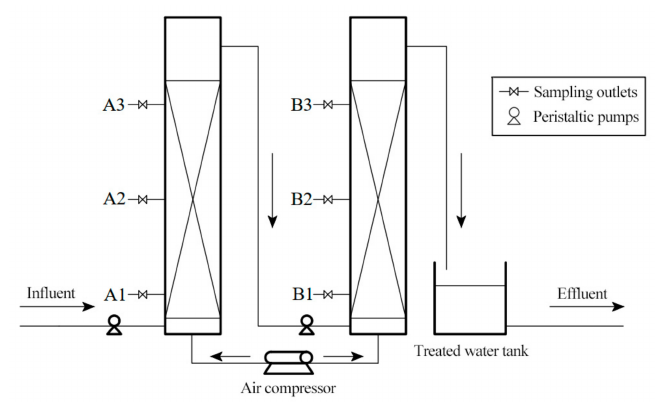
Figure 1. Schematic diagram of the two-stage biological aerated filter (BAF)